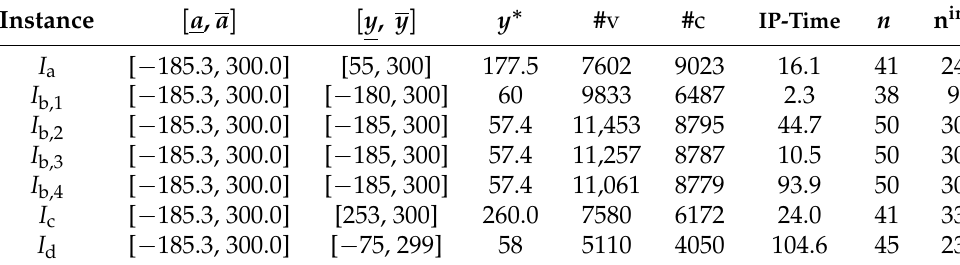
Table 9. Results of Stage 4 for M P